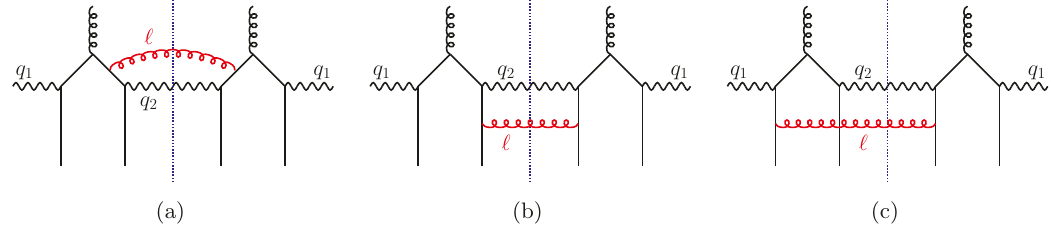
Figure 10 . Radiative corrections to the hard scattering graph in figure 8a that give rise to DGLAP